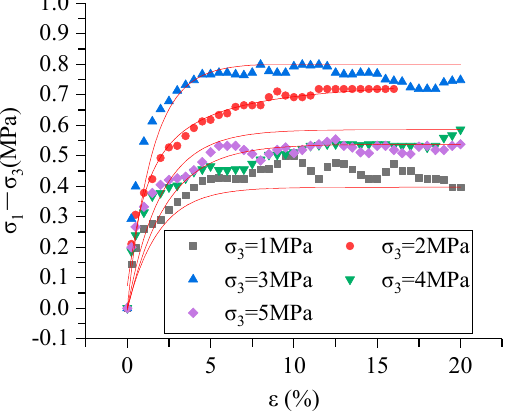
Figure 8. Triaxial stress–strain curves of sediments containing spherical hydrates ( 𝑟 = 5𝑚𝑚 ).